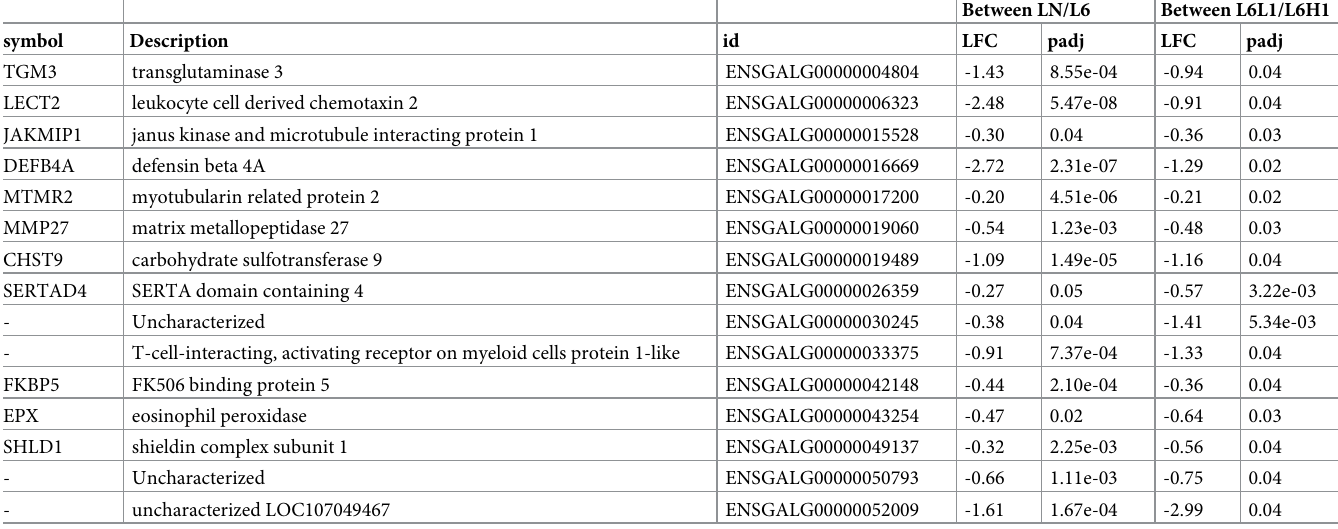
Table 4. Common differentially expressed genes upregulated between LN/L6 analysis and LNL1/LNH1 analysis (potentially associated with susceptibility to Salmonella ).